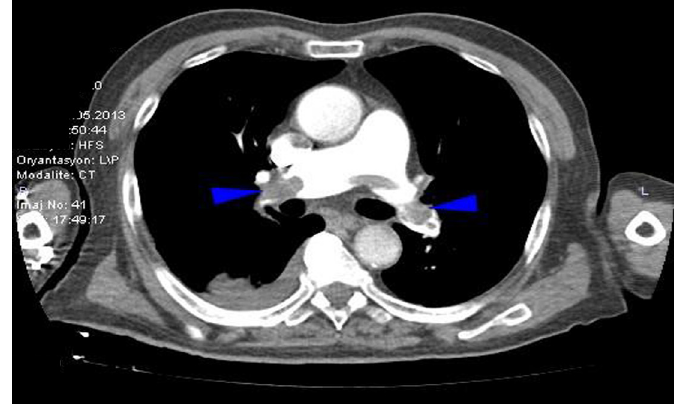
Figure. Blue arrow heads show filling defects in both main pulmonary arteries in computerized tomographic angiography of the